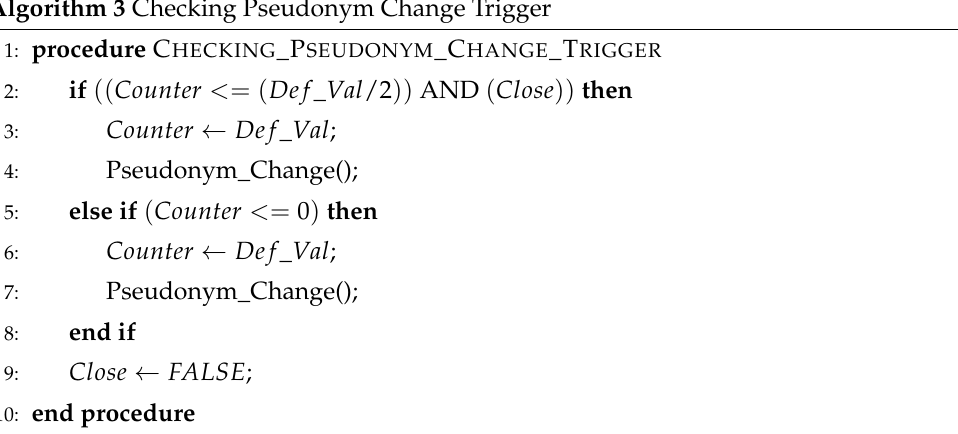
Figure 9. WHISPER, pseudonym change process triggered by a close neighbor’s status. Algorithm 3 Checking Pseudonym Change